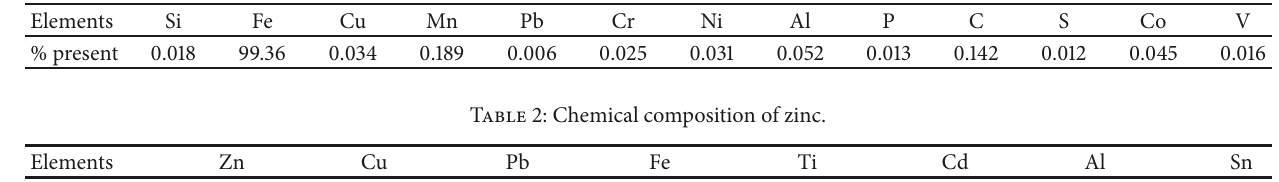
Table 1: Chemical components of mild steel.